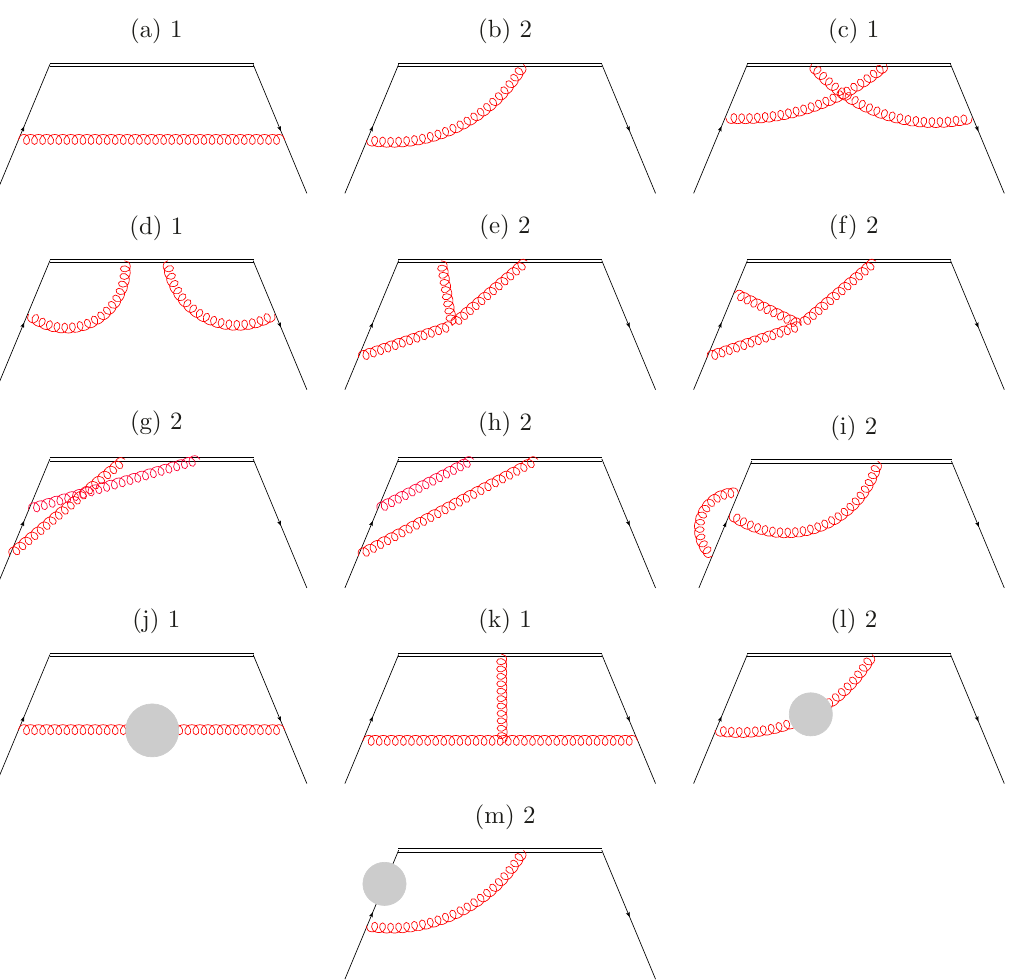
Figure 4. Large- x divergent contributions to the quark-quark parton distribution up to two loops. The grey blob represents a self energy insertion. Each diagram has a multiple factor displayed. Insertions on external legs are